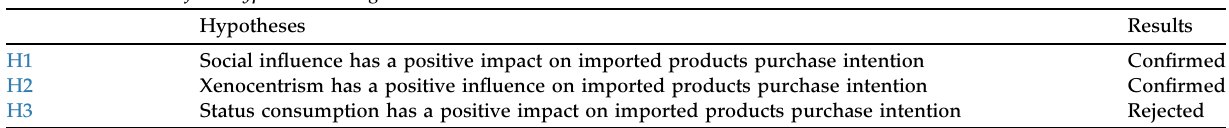
Table 3. The results of the hypothesis